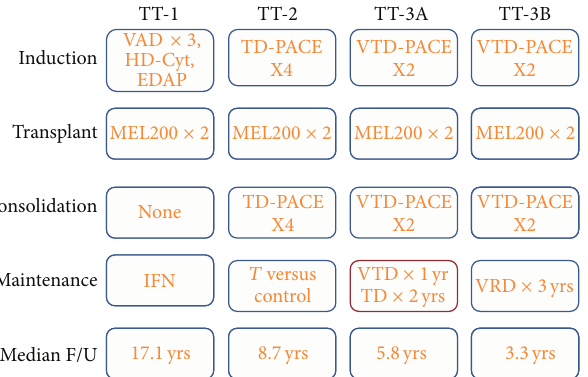
Figure 6: It summarizes the series of Total therapy trials. VAD: vincristine, doxorubicin, and dexamethasone; HD-Cyt: high-dose cyclophosphamide; EDAP: etoposide, dexamethasone, cytarabine, and cisplatin; TD-PACE: thalidomide, dexamethasone, cisplatin, doxorubicin, cyclophosphamide, and etoposide; VTD: bortezomib, thalidomide, and dexamethasone; VRD: bortezomib, lenalidomide, and